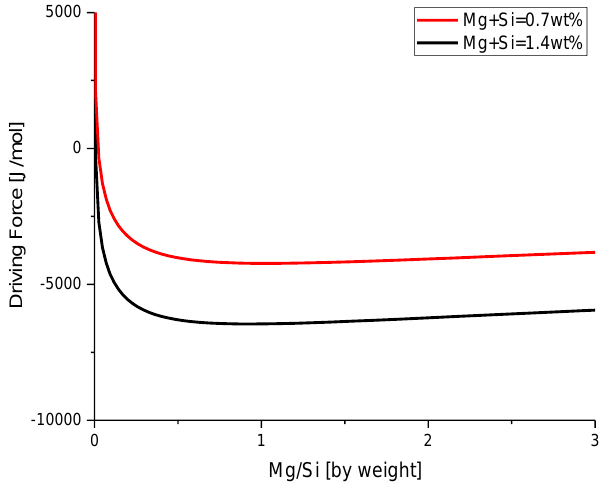
Figure 20. Driving force for β″ precipitation at 175 °C out of ternary Al-Mg-Si solid solutions as a function of Mg/Si, for Mg + Si = 0.7 and 1.4 wt %; Calculated with Thermo-Calc [56].